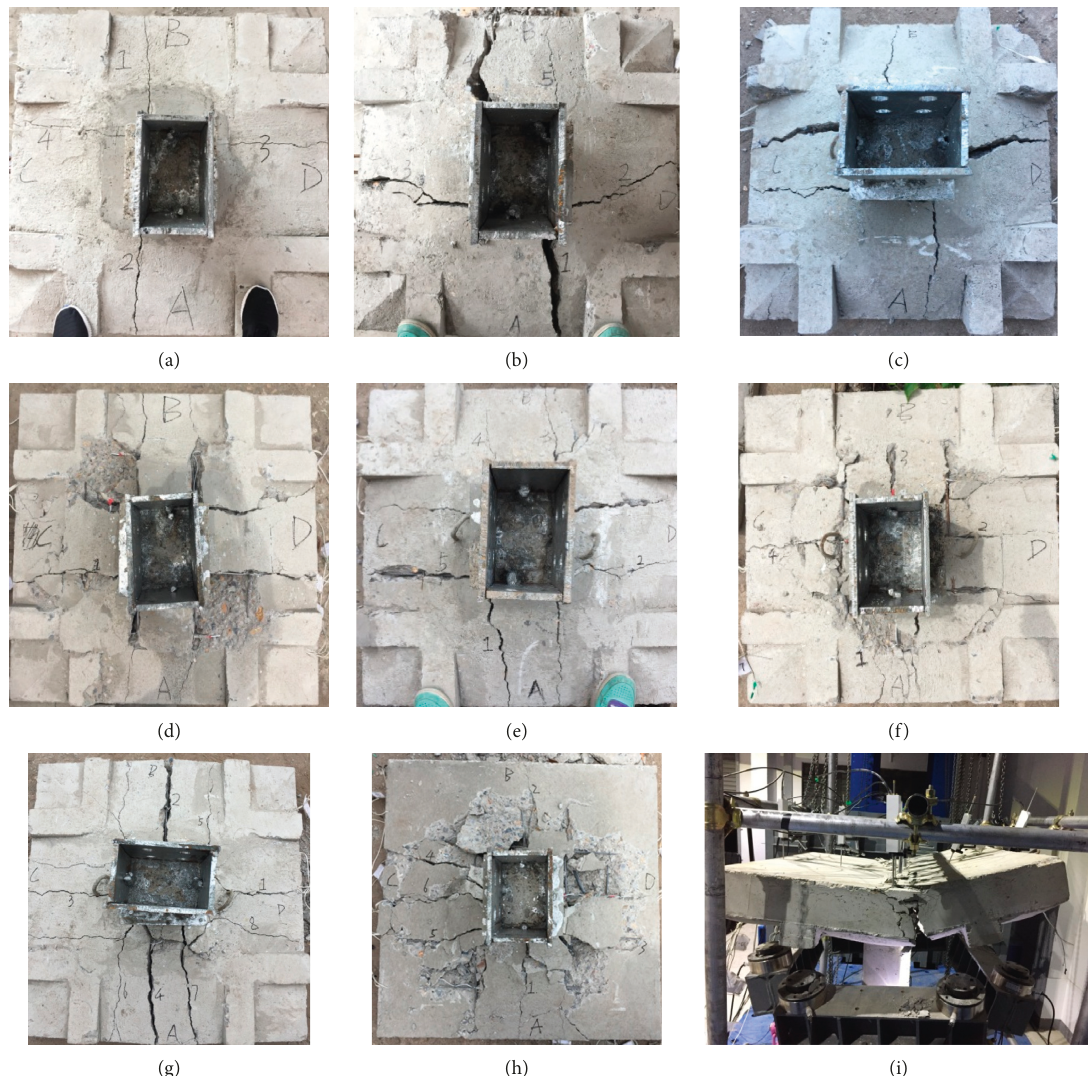
Figure 6: Failure modes for the specimens. (a) NJ1. (b) NJ2. (c) NJ3. (d) NJ4. (e) NJ5. (f) NJ6. (g) NJ7. (h) NJ8. (i) Deformation of the specimen